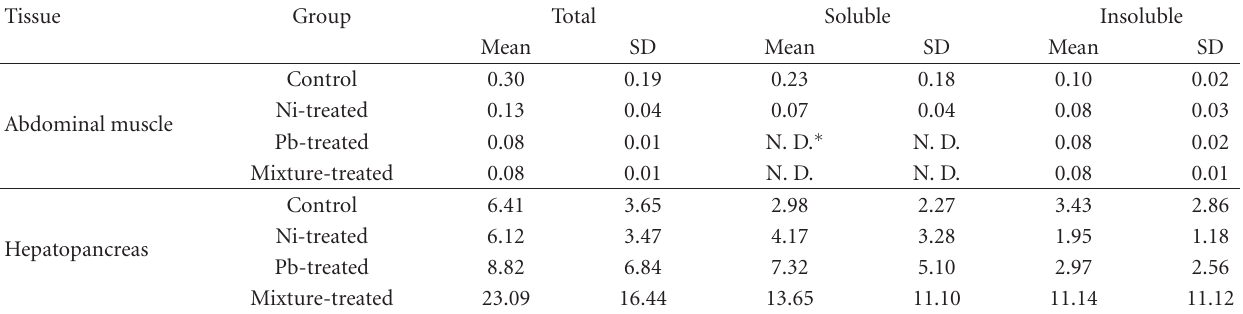
Table 2: Nickel concentration ( μ gg − 1 ) in abdominal muscle and hepatopancreas from P. vannamei, at the soluble and insoluble fraction. Tissue